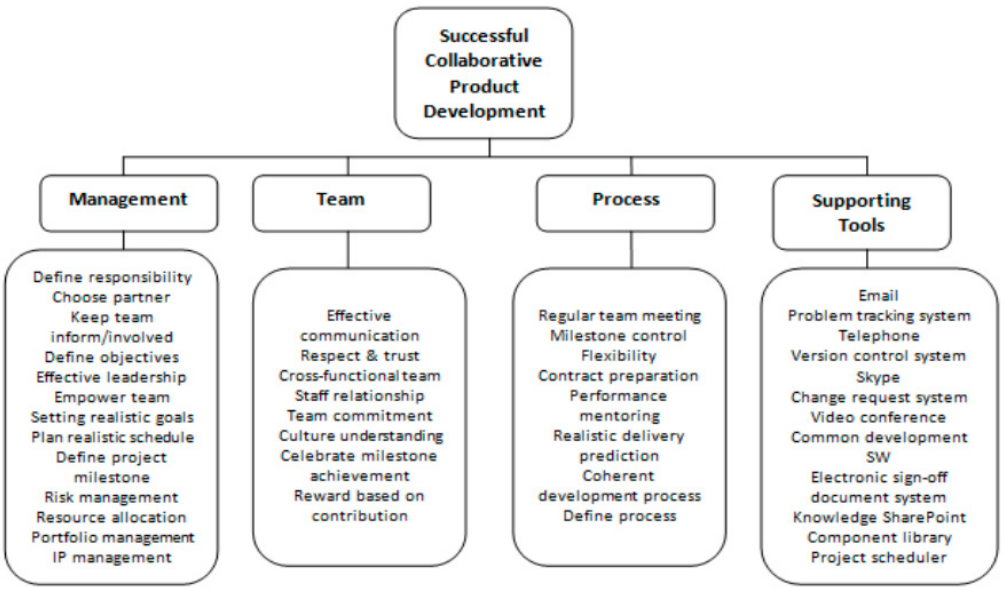
Figure 1. Critical success factors framework (CSF) for collaborative product development, sourced from [21].